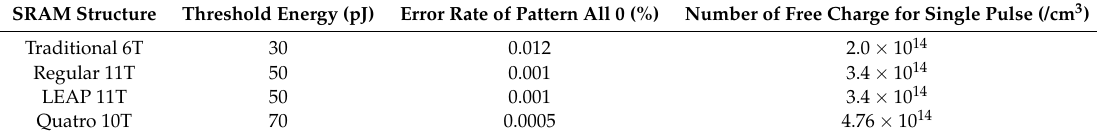
Table 3. Comparison between Laser Threshold Energy and Alpha Radiation Error rate for each SRAM